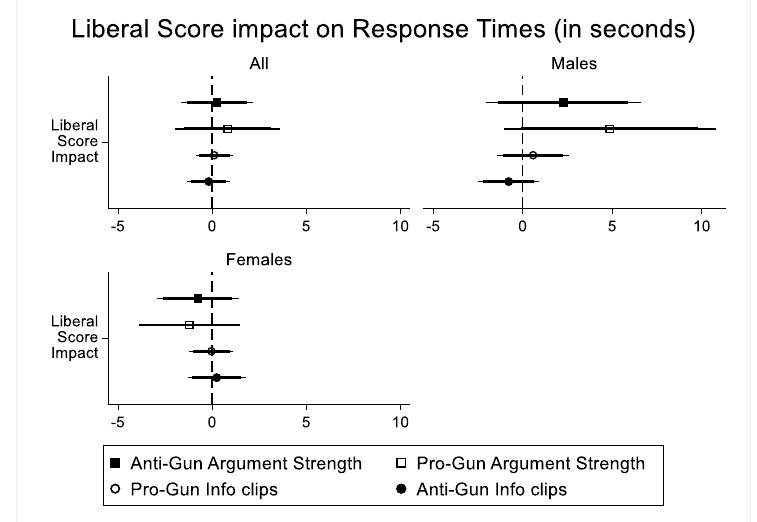
Figure A3. Impact of Liberal Score ∈ (1,5) on Response Times (RT). (RT averaged across all Pro-Gun or Anti-Gun info clips views or arguments assessed). Notes: Models included full set of control variables (age, gender, minority status, Epworth (daytime) sleepiness score, morningness-eveningness preference (rMEQ), SR assignment, prosociality, backwards induction skill, and cognitive reflection score), as well as the inverse probability weight correction for sample selection (based on the selection model estimates in Appendix Table A1). Thin (thick) lines around point estimates represent the 95% (90%) confidence intervals. Full estimation results available on request.